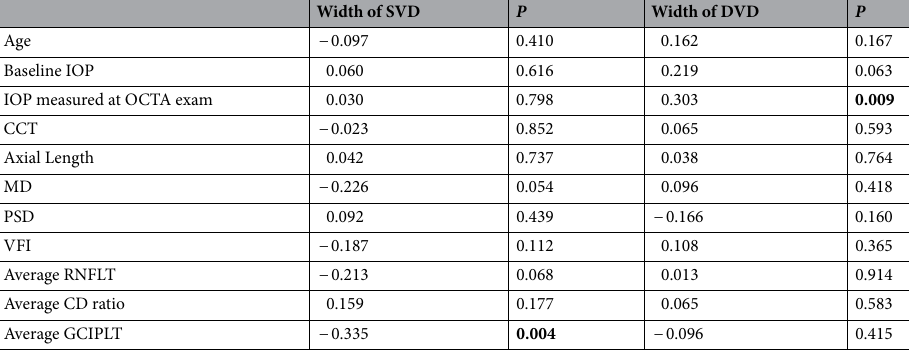
Table 2. Correlation coefficients between the width of vessel defect in each layer and structural or functional parameters in all eyes. SVD superficial vessel defect, DVD deep vessel defect, IOP intraocular pressure, OCTA optical coherence tomography angiography, CCT central corneal thickness, MD mean deviation, PSD pattern standard deviation, VFI visual function index, RNFLT retinal nerve fiber layer thickness, CD cup to disc, GCIPLT ganglion cell inner plexiform layer thickness. Bold font indicates significant P values ( P < 0.05). Pearson correlation analysis was